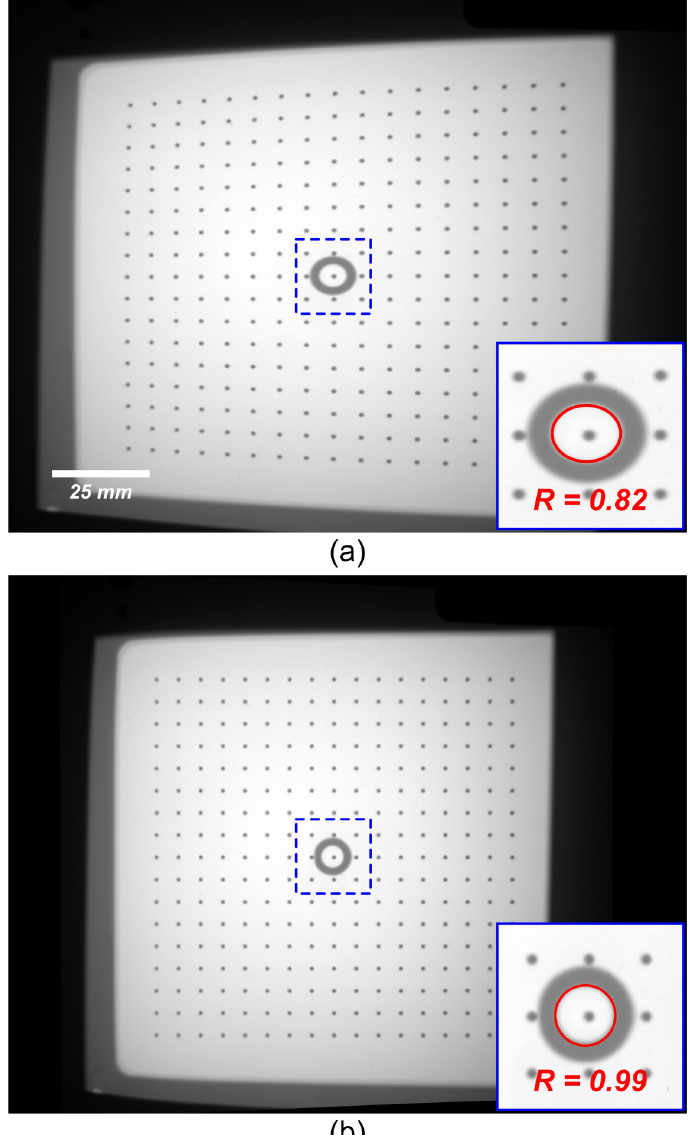
Fig 4. Assessment of geometric distortion correction resulting from the tilted-detector configuration. (a) shows the un-corrected raw data of the Cartesian calibration grid. (b) corrected image of the Cartesian calibration grid. capturing a projection image of a precisely fabricated 80 x 80 mm grid containing 17 rows by 17 columns of 0.5 mm diameter high-contrast metal marker beads. The centroid of each marker bead was determined to subpixel accuracy and used to correct the image based on the a priori knowledge about the Cartesian grid [23]. Source and detector alignment was estimated using a ring-shaped high-contrast object that was placed 80 mm from the plane of the Carte- sian grid toward the x-ray source [24]. Proper alignment of this ring and the central marker of the grid was visually confirmed before data acquisition (Fig 4). The accuracy of the correction was evaluated, primarily, by imaging a cylindrical phantom with a series of high-contrast metal beads placed on the outer surface of the cylinder parallel to its longitudinal axis. The